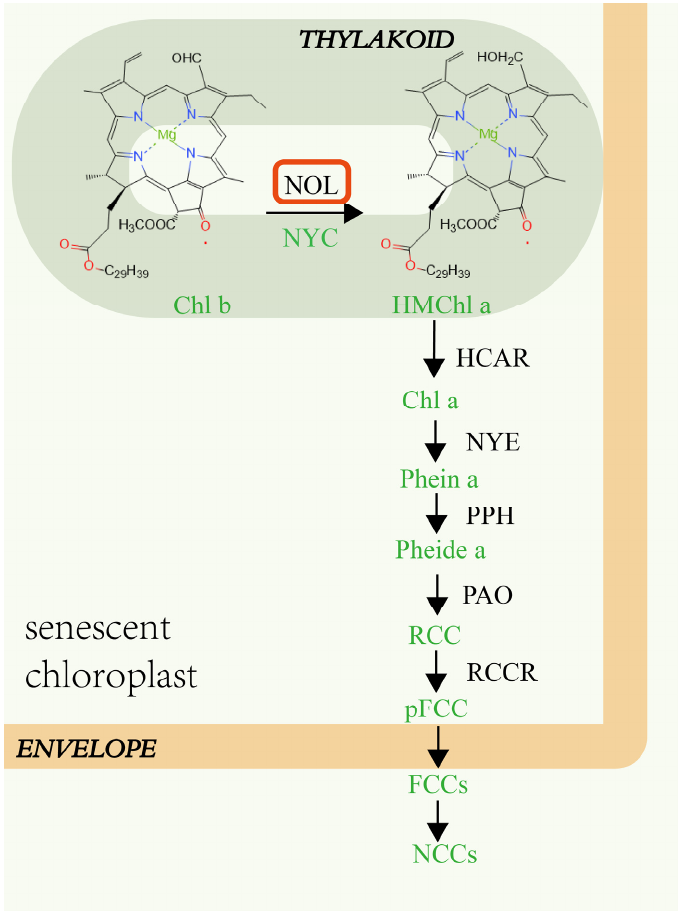
Figure 1. NOL is involved in regulating chlorophyll degradation in a senescing mesophyll cell of Arabidopsis thaliana [5]. HMChl a, 7-hydroxymethyl chlorophyll a; HCAR, chlorophyll a reductase; NYE, non-yellowing 1; PPH, pheophytinase; PAO, pheophorbide a oxygenase; RCCR, red chlorophyll catabolite reductase; RCC, red chlorophyll catabolite; pFCC, primary blue-fluorescent chlorophyll catabolite; FCCs, fluorescent chlorophyll catabolites; NCCs, nonfluorescent chlorophyll catabolites; Pheide a, pheophorbide a; Phein a, Pheophytin a. In Arabidopsis thaliana , overexpressed NOL plants had a considerably lower chlorophyll content than wild-type plants, and photosystem II had a reduced antenna size, indicating that NOL was engaged in photosystem II antenna size control [9]. A phylogenetic study of the rice ( Oryza sativa ) OsNOL gene revealed that the closest protein to OsNOL was OsNYC1 . Rice nol mutants exhibited a phenotype similar to that of the nyc1 mutant, with significant suppression of chlorophyll b degradation. Additionally, LHCII was preserved selectively throughout senescence and thylakoid grana were retained even at a late stage of senescence [10]. The LpNOL RNA interference ( NOLi ) in perennial ryegrass ( Lolium perenne ) dramatically suppressed chlorophyll breakdown during leaf senescence and altered